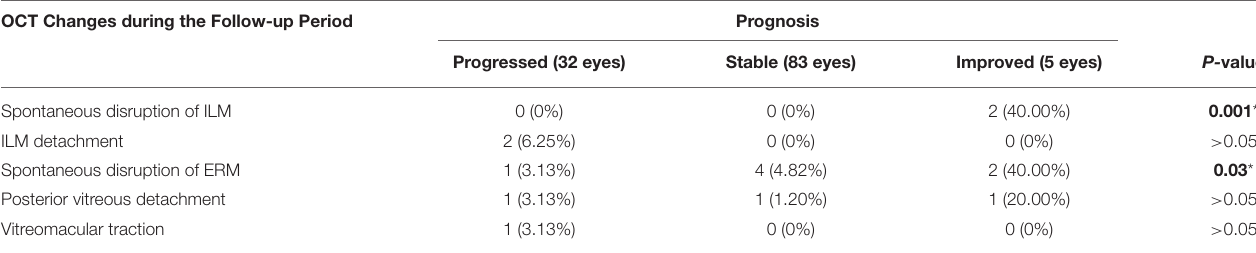
TABLE 3 | Changes of OCT features in patients with different